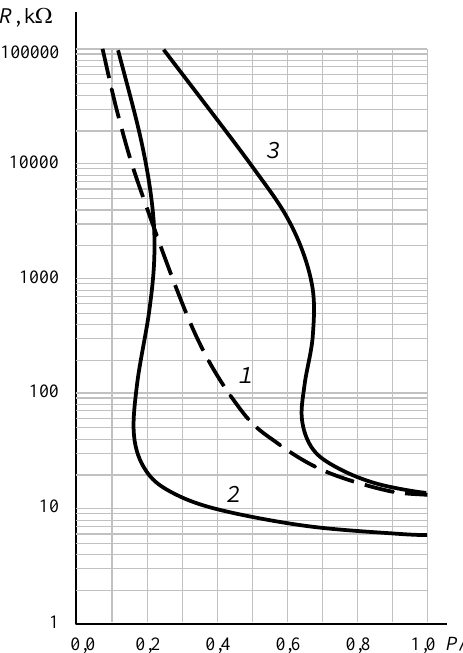
Fig. 2. The R ( P / P S ) dependences at β 0 = 2, C = 5,87 ( 1 ); β 0 = 1, C = 5,87 ( 2 ); and